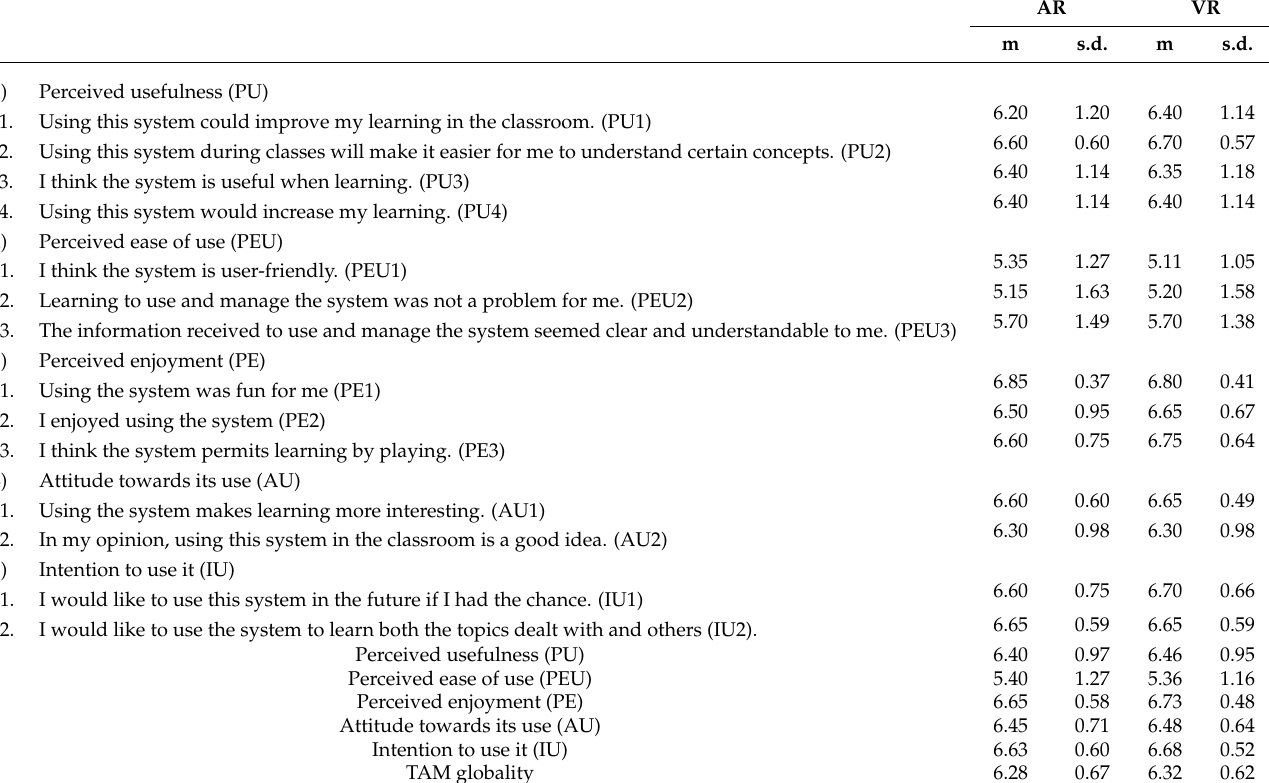
Table 3. Means and standard deviations reached with the instrument related to the TAM